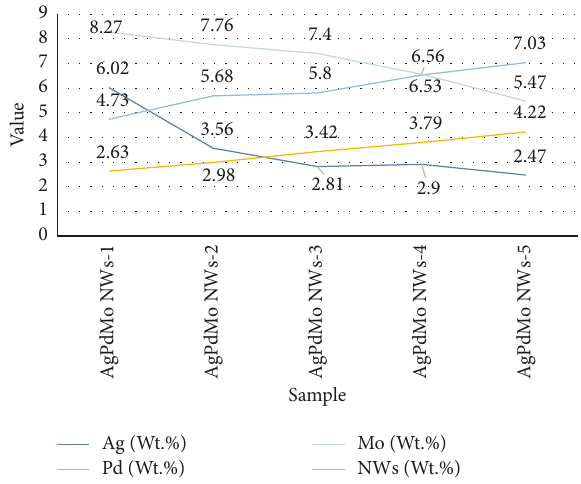
Figure 5: Atomic emission spectroscopy